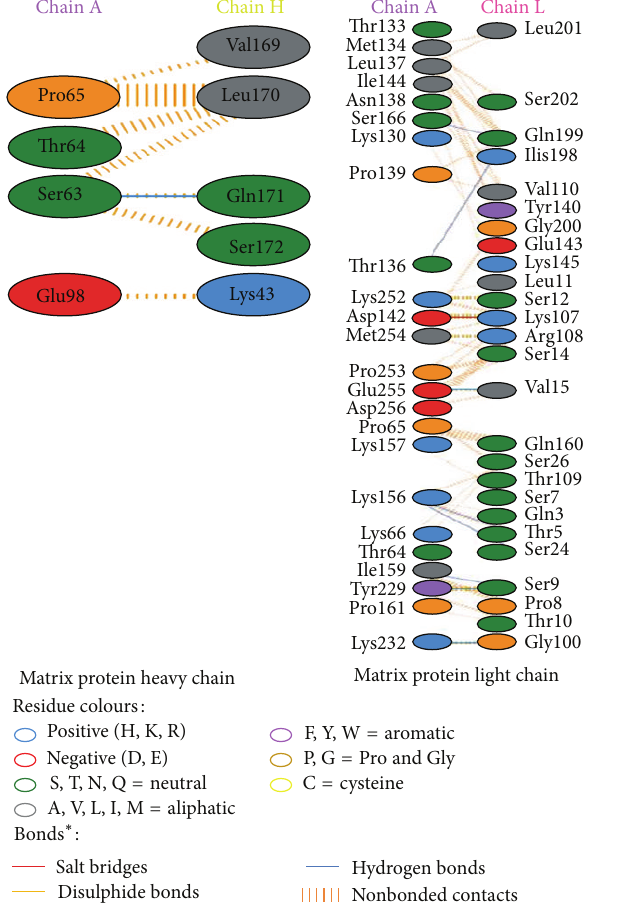
Figure 6: Interaction of matrix protein and motavizumab showing interaction of residues with heavy and light chain through various bonds ∗ .